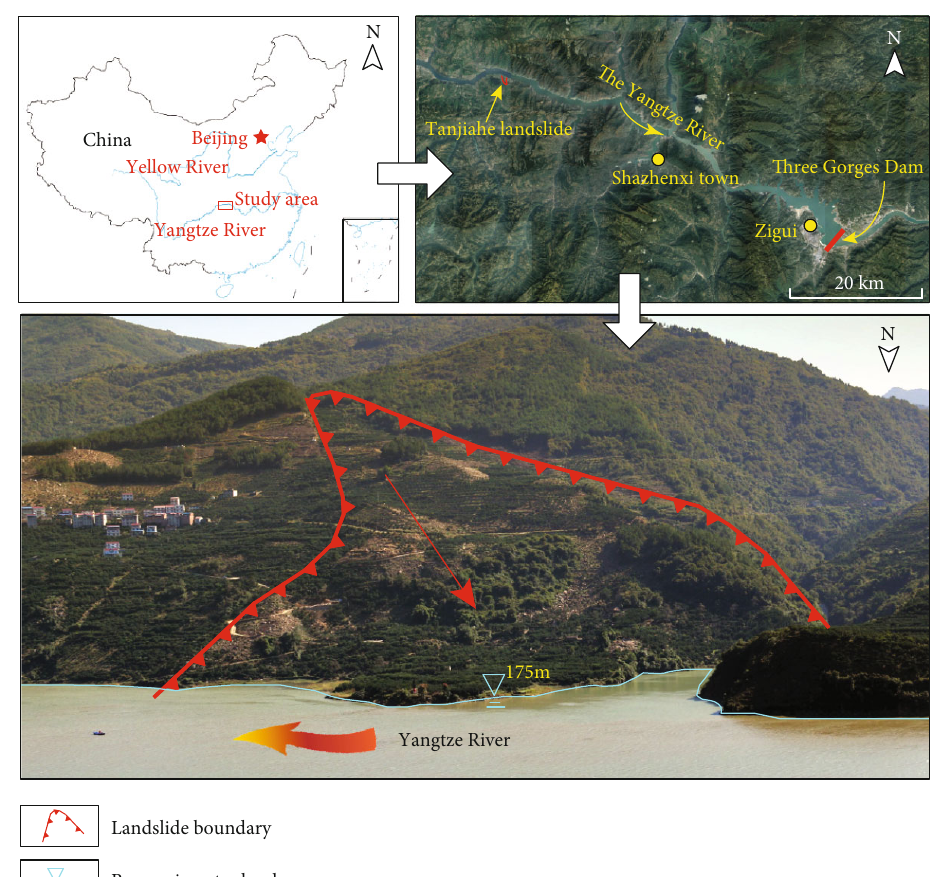
Figure 2: Location and geomorphological delimitation of the Tanjiahe